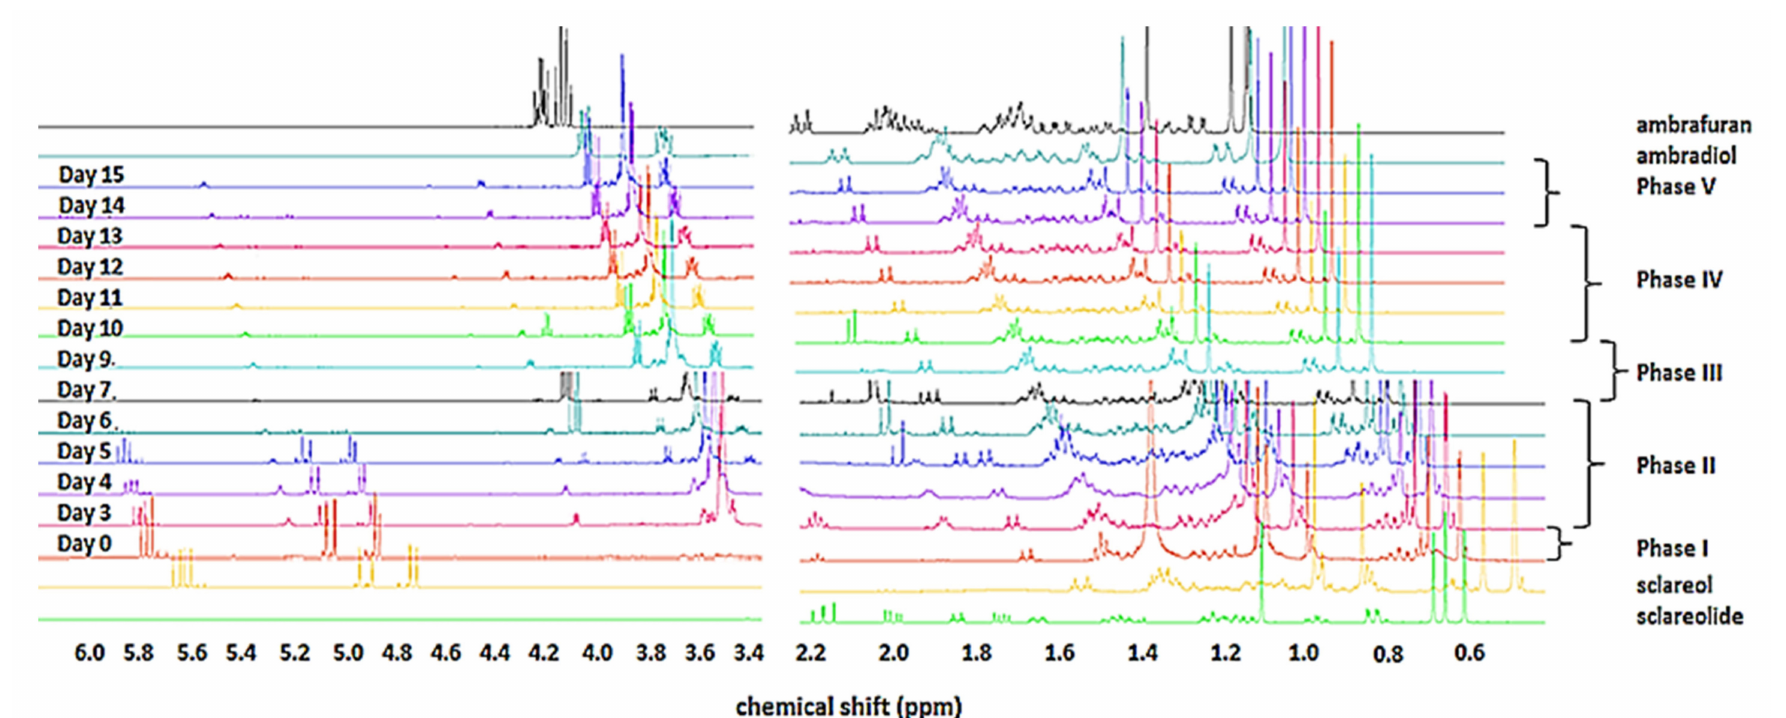
Figure 1. Representative 1H NMR spectra (600 MHz) of ethyl acetate extracts from Hyphozyma roseoniger in batch culture, sampled during the bioconversion phases. All spectra were referenced against residue protonated chloroform in the solvent (7.26 ppm). Phases I–V correspond to the growth stages of the organism in batch culture (Figure S1) and the methodology applied to the UHPLC-MS results. The period between days 0–3 indicates the induction period (phase I). Spectra of the standards are included for reference (sclareol and sclareolide below the spectral stack, ambradiol and ambrafuran above